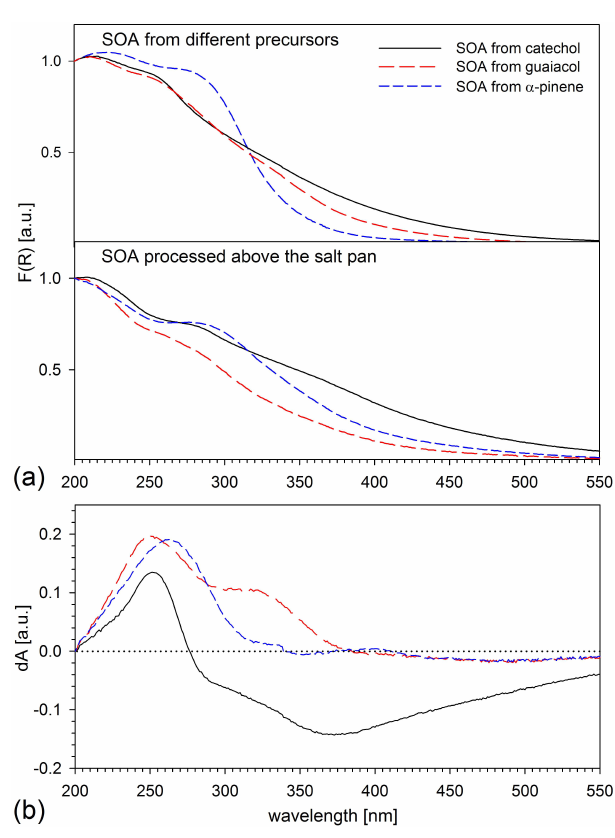
Fig. 10. Single absorption spectra F(R) (a) and change of the dif- ferential absorbance (dA) (b) in the UV/VIS region due to the reac- tion of the organic aerosols with RHS released from the simulated salt pan, indicating a chlorination of the SOA (by comparison with Fig. 3).